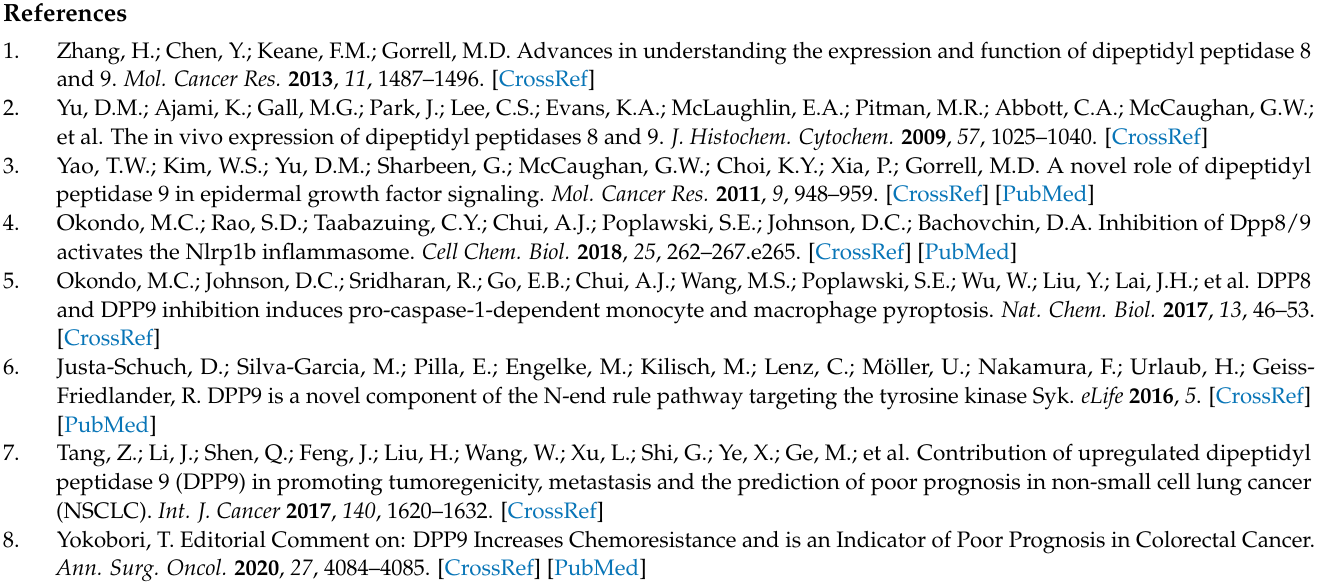
mographics, Table S5: Cox proportional hazards model with gender as the covariate to evaluate associations between DPP9 expression and survival, Table S6: Cox proportional hazards model with BMI as the covariate to evaluate associations between DPP9 expression and survival. Figure S1: Crys- tal structure and protein sequence of the four enzymatic members in the DPP4 gene family, Figure S2: DPP9 variants mapping to the DPP9 protein structure, Figure S3: Enriched reactome pathways of genes that were negatively correlated and in-common between DPP9 and DPP8 , Figure S4: Survival analysis on genes that were positively correlated and in-common amongst DPP9, DPP8, DPP4 and FAP in